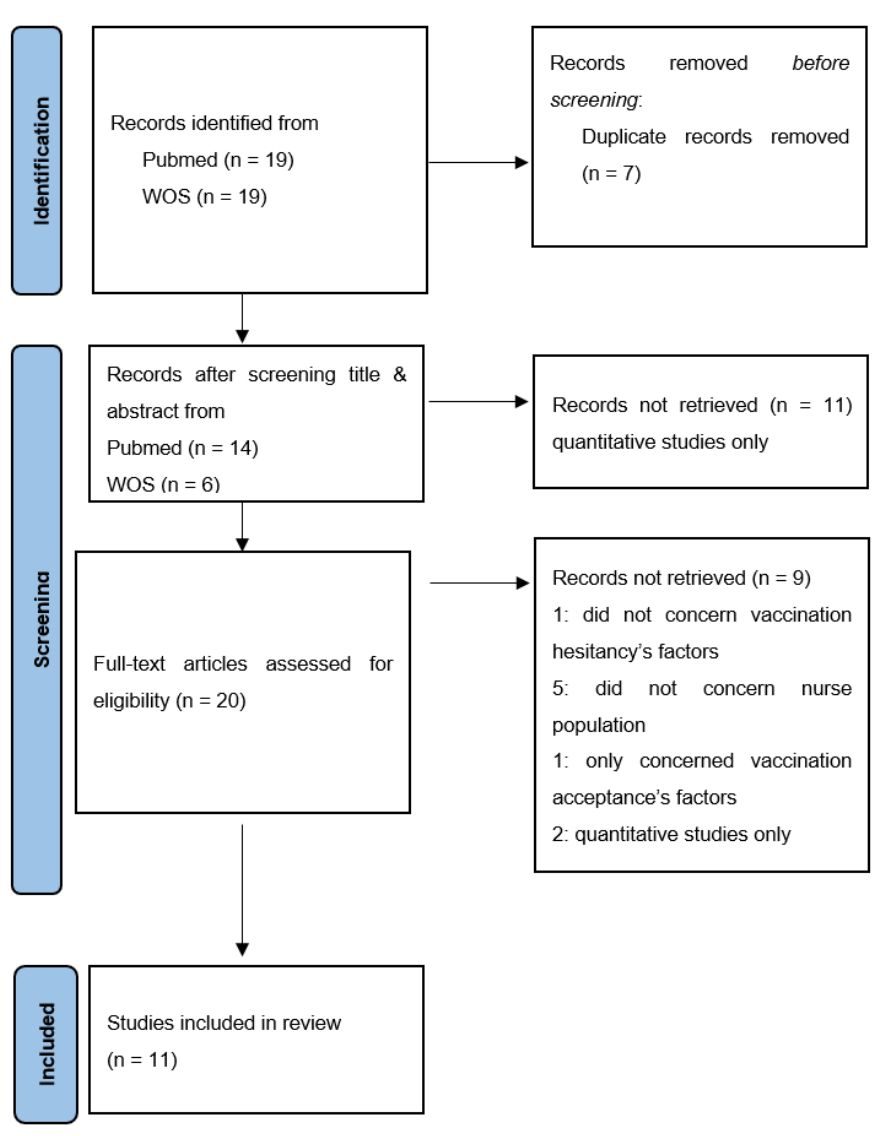
Figure 1. Flow diagram for systematic review: nurses’ influenza vaccination and hesitancy.